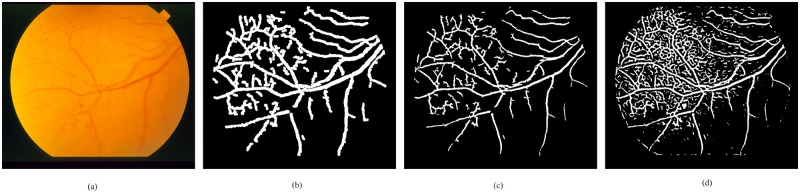
Analysis of using OR operator.(a) RGB input image (b) VLM (c) Frangi enhanced, thresholded image (d) OR Operator result.